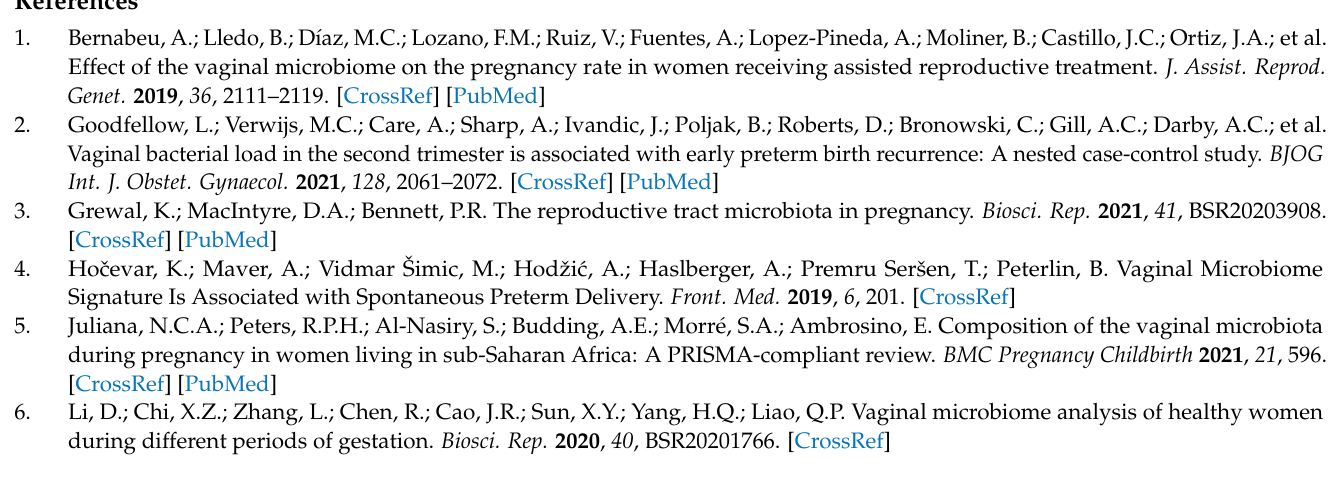
samples. (A) Stacked bar charts representing relative abundance of genus. (B) Stacked bar charts representing relative abundance of species. Each bar represents one sample. Negative-control rep- resents samples with empty swab for DNA extraction and amplified nuclease-free water without extracted DNA. Figure S4: Relative abundance of non-Lactobacillus species across the three trimesters of pregnancy in comparison to non-pregnant state. Negative-control represents samples with empty swab for DNA extraction and amplified nuclease-free water without extracted DNA. Table S1: Age of participants; Table S2: Relative abundance of taxa at phylum level. Table S3: Relative abundance of taxa at genus level. Table S4: Relative abundance of Lactobacillus species. Table S5: Relative abundance of non- Lactobacillus . Table S6: VALENCIA CST classification output revealed similarity of vaginal microbiota profile of individual sample to each of 13 reference centroids producing 13 similarity scores ranging from 0.0 to 1.0 for each sample. Table S7: Alpha diversity using Pielou’s evenness by measuring Kruskal-Wallis test (pairwise) revealing non-significant difference. Table S8: Spearman correlation between the relative abundances of vaginal microbial communities at phylum level and their p values. Table S9: Spearman correlation between the relative abundances of vaginal microbial communities at genera level and their p values. Table S10: Spearman correlation between the relative abundances of vaginal microbial communities at species level and their p values. Software code S1: R scripts used for downstream